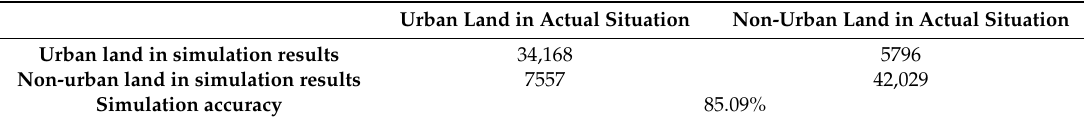
Table 7. Simulation accuracy results of MHABC-CA algorithm in error matrix form.